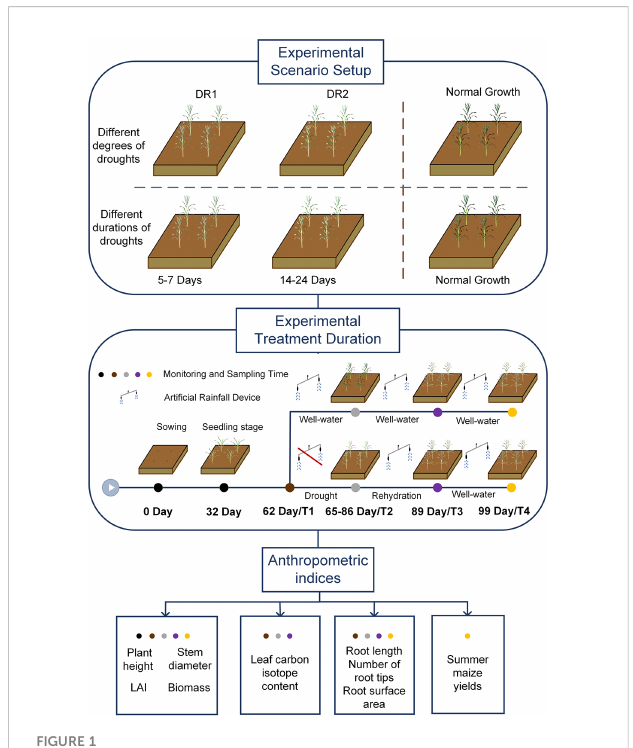
FIGURE 1 The speci fi c process of the experiment. DR1, Light drought; DR2, Moderate drought; T1, before drought; T2, drought period; T3, rehydration period; T4, harvest